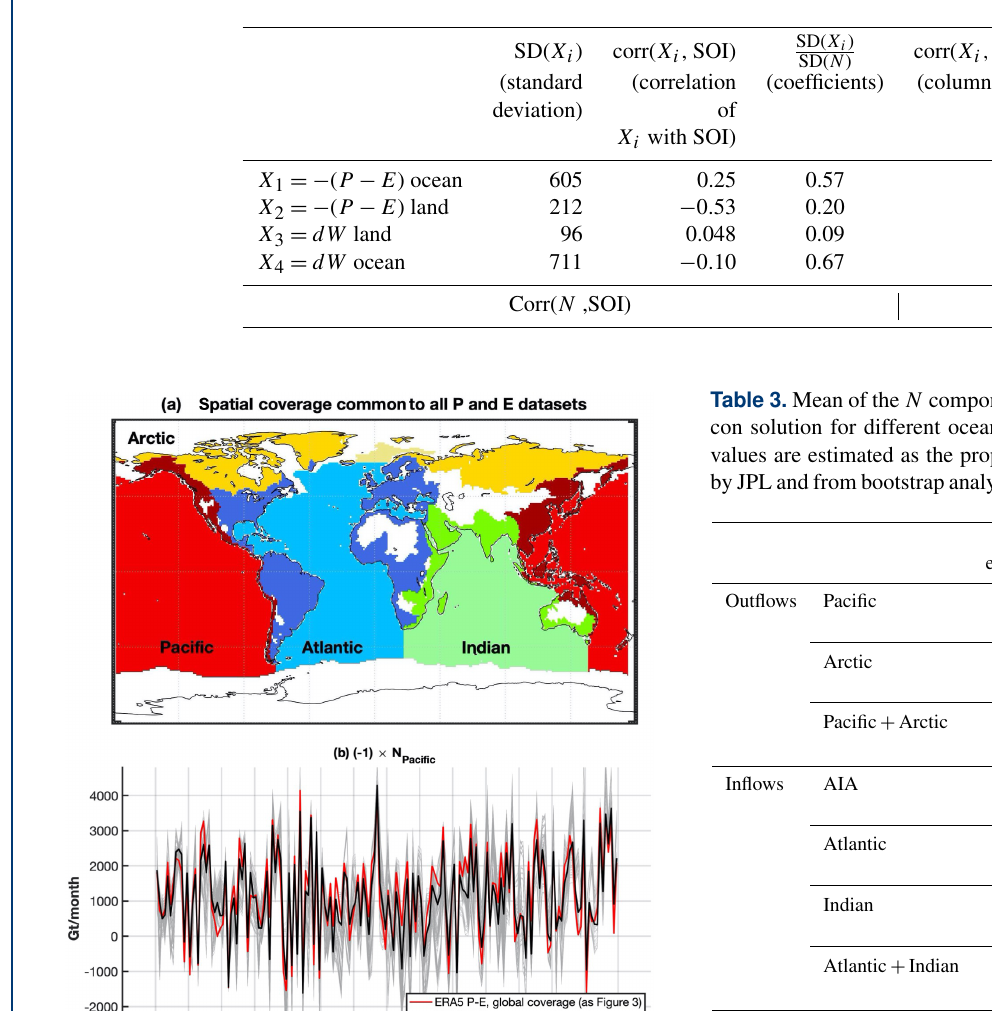
Table 2. Correlation coefficients between the SOI and the de-trended and de-seasonalized WT components involved in the estimate of the Pacific outflow according to Eqs. (3) and (4).